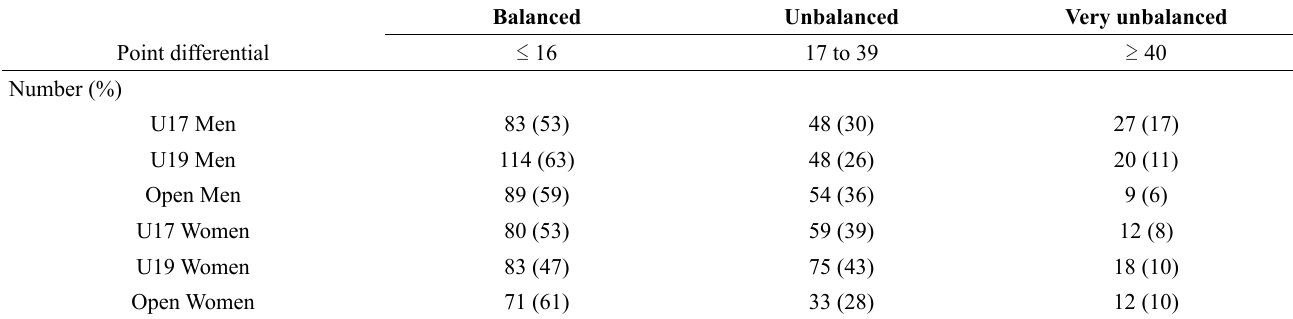
Table 1. Game classification by final point differentials